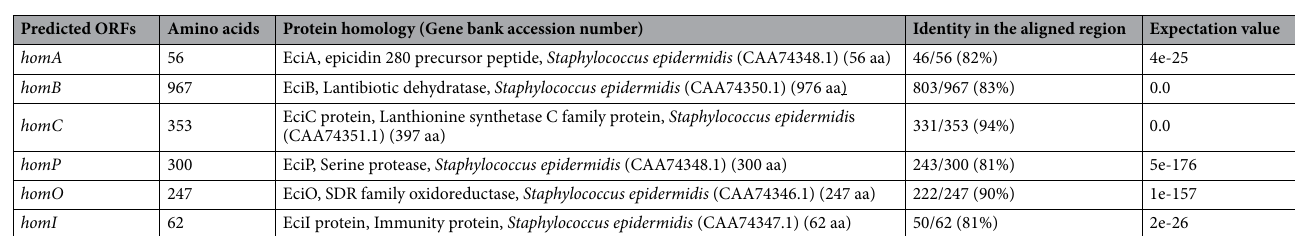
Table 1. Open reading frame analysis of the homicorcin gene cluster using